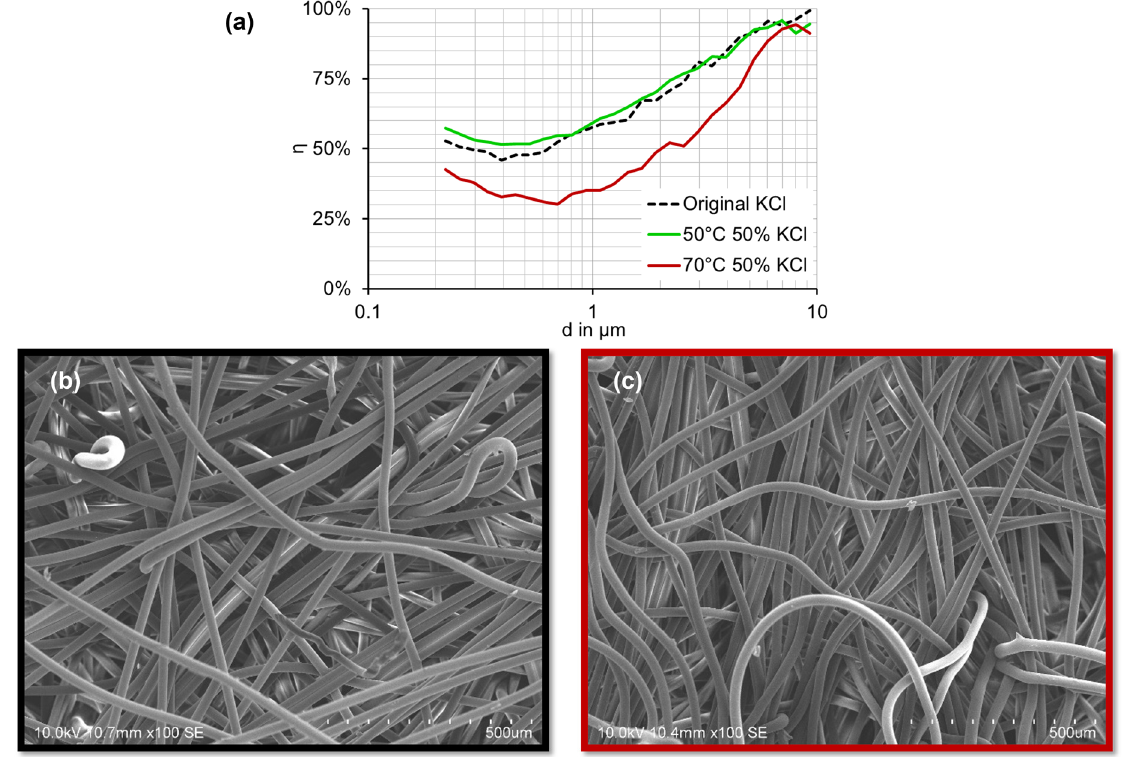
Figure 8. ( a ) Separation efficiency η of PLA nonwoven NW-L tested using generated KCL particles before (original) and after artificial aging at indicated conditions. ( b , c ) SEM images of original nonwoven and nonwoven after aging at 70 ◦ C and 50%